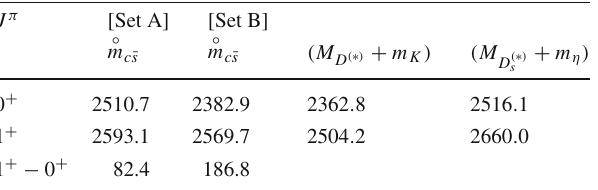
◦ m c ¯ s CQM bare masses and the D ( ∗ ) K and Table 1 The two sets of D ( ∗ ) s η averaged threshold energies (in MeV units) used in this work, taken from Ref. [78]. In addition, we take an average kaon mass of m K = 495 . 6